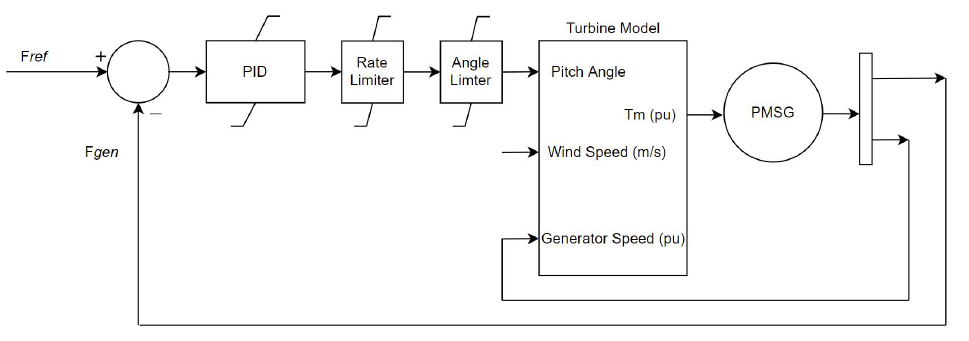
Figure 6. Control and Simulation Diagram for the Pilot